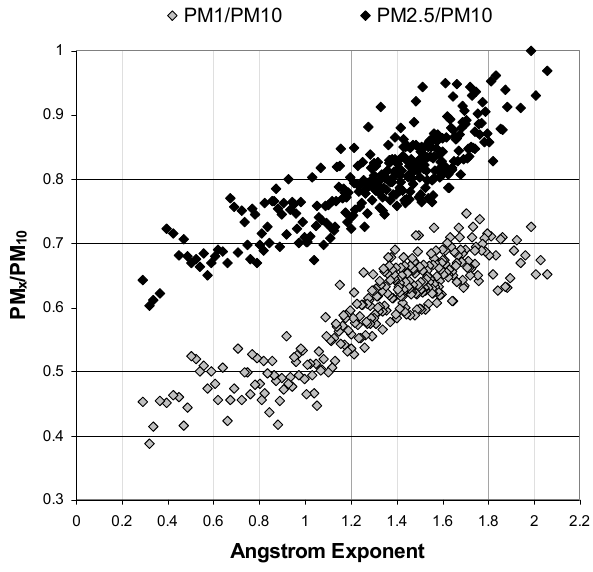
Fig. 4. Correlation between PM 1 /PM 10 and PM 2 . 5 /PM 10 and ˚Angstr¨om exponent.